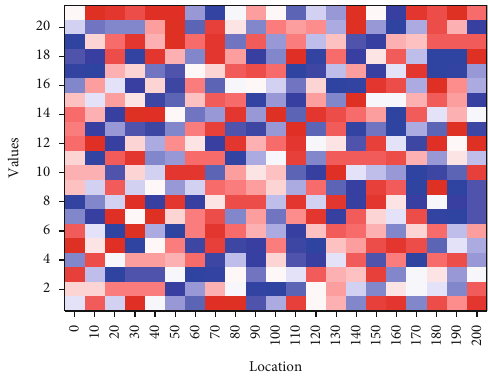
Figure 6: Visualization of the depth features of the target